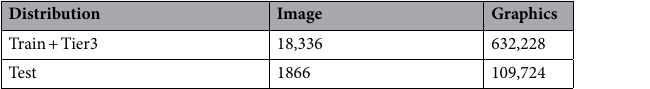
Table 2. The xBD data distribution and their respective annotation